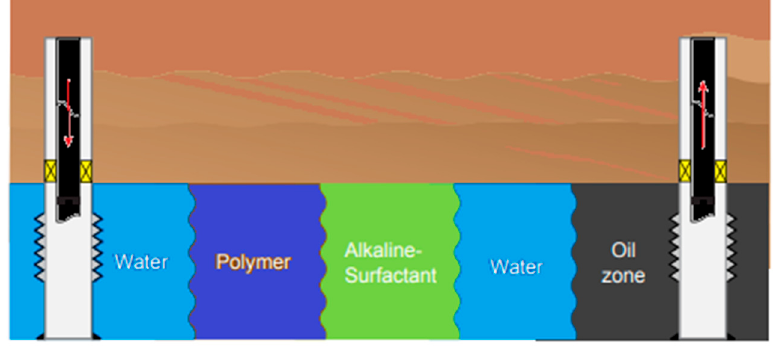
Figure 5. Diagrammatic representation of ASP flooding